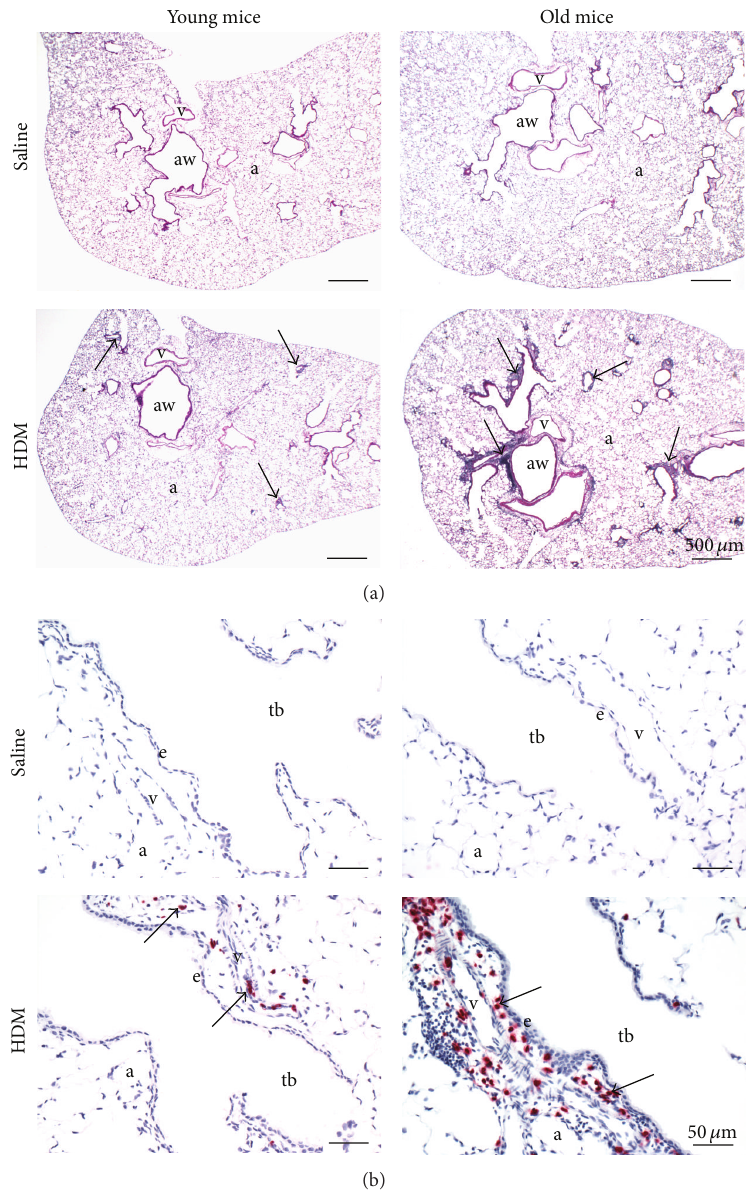
Figure 1: Pulmonary histopathology. (a) Representative light photomicrographs of lung tissue sections, stained with hematoxylin and eosin, showing a peribronchiolar and perivascular mixed inflammatory cell infiltration in HDM mice (arrows). aw: airways; a: airspace; v: blood vessel; scale bar: 500 𝜇 m. (b) Accumulation of major basic protein positive eosinophils (arrow) in the perivascular and peribronchiolar region of young and old HDM mice. tb: terminal bronchioli; a: alveoli; v: blood vessel; scale bar: 50 𝜇